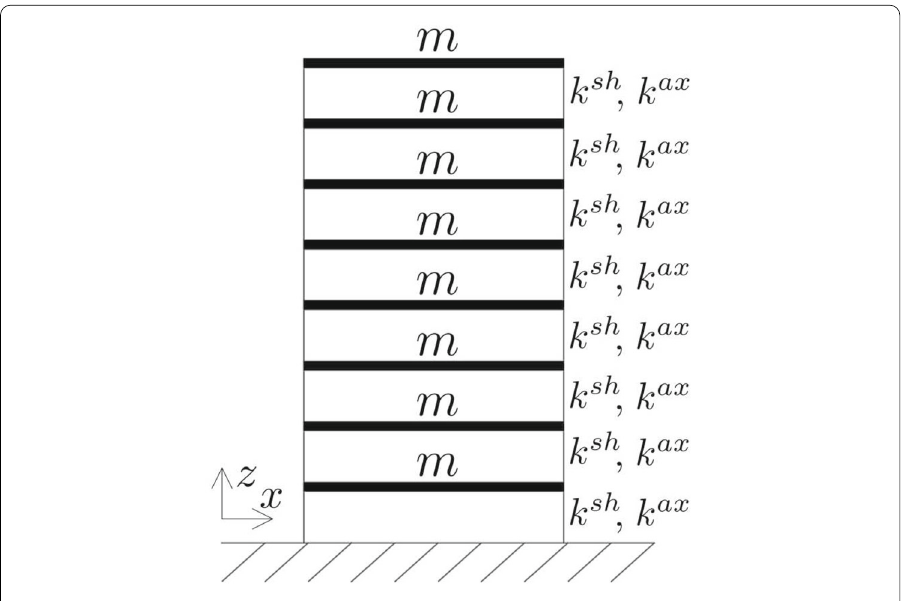
Fig. 5 Linear elastic shear model of an eight-story building with constant story mass and constant story